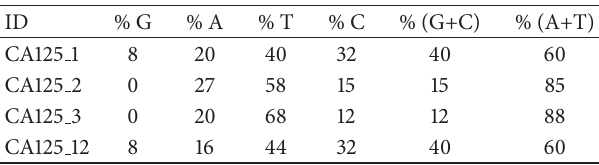
Table 3: Proportions of the four nucleobases in the CA125 aptamer candidates chosen for in vitro